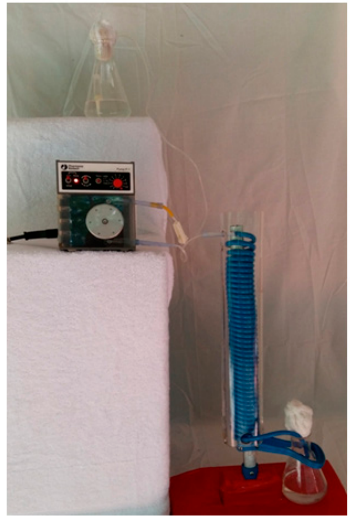
Fig. 1. Working condition of PU based bioreactor